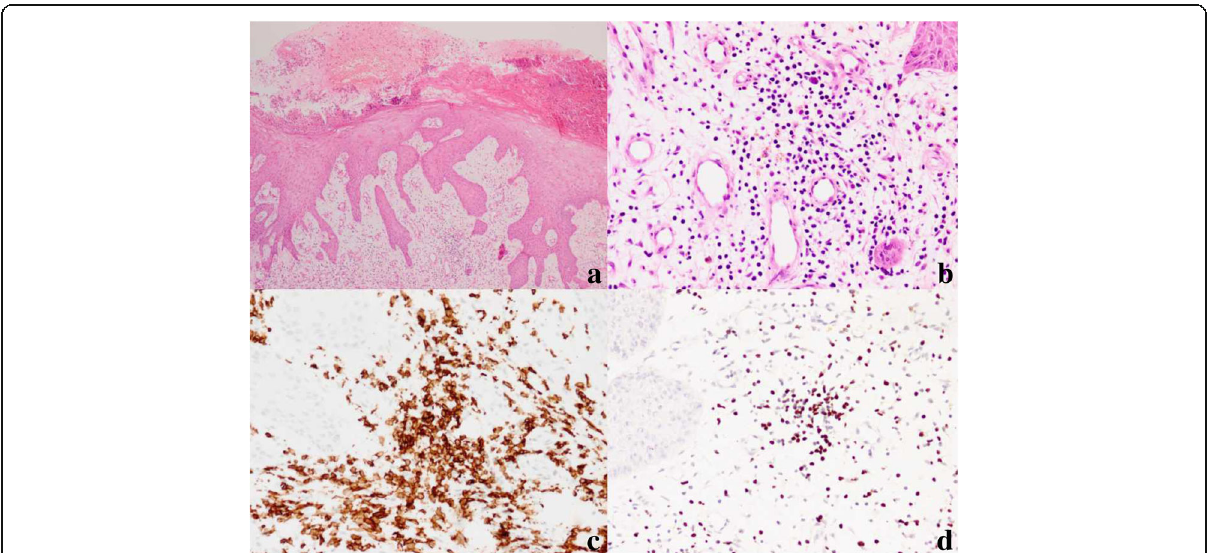
Fig. 2 HV-LPD morphology and immunophenotype of case 10. a Skin biopsy shows edema and vesicles in the epidermis (hematoxylin and eosin [H&E], 40×). b Skin biopsy shows an infiltration of atypical lymphocytes surrounding adnexa and blood vessels (H&E, 200×). c Immunohistochemical CD8 stain shows that the cells surrounding the adnexa and blood vessels are strongly CD8-positive (200×). d In situ hybridization for EBV-encoded RNA showed positive signals in infiltrating lymphocytes